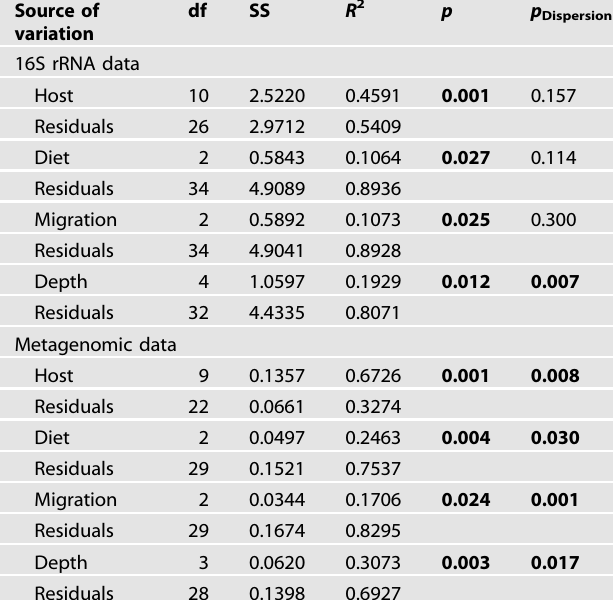
Table 4. PERMANOVAs assessing abundance of metabolic categories in relation to host species, depth, diet and diel vertical migration based on a 16S rRNA amplicon data and b shotgun metagenomic